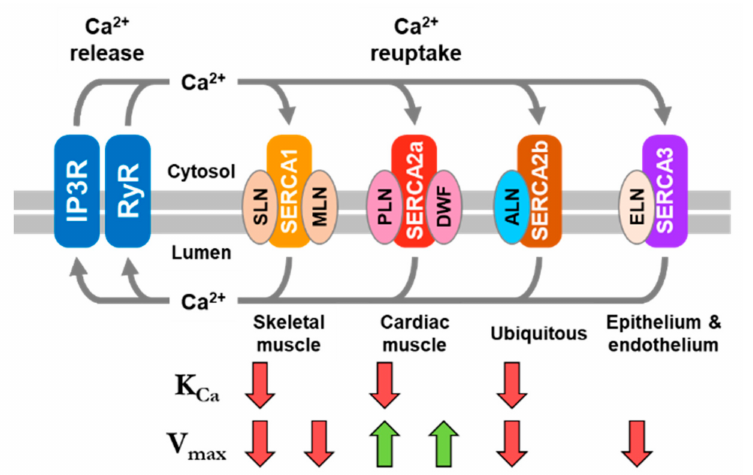
Figure 9. Schematic representation of the expression patterns of the regulins and SERCA isoforms in different muscle and non-muscle tissues in vertebrates (adapted from [24]). The effects of the different regulins on the apparent calcium affinity (K Ca ) and maximal activity (V max ) of SERCA are indicated by arrows. Red arrows indicate a decrease in the apparent calcium affinity (K Ca ) or maximal activity (V max ), green arrows indicate an increase in the maximal activity (V max ), no arrows indicate no effect on the apparent calcium affinity (K Ca ) of